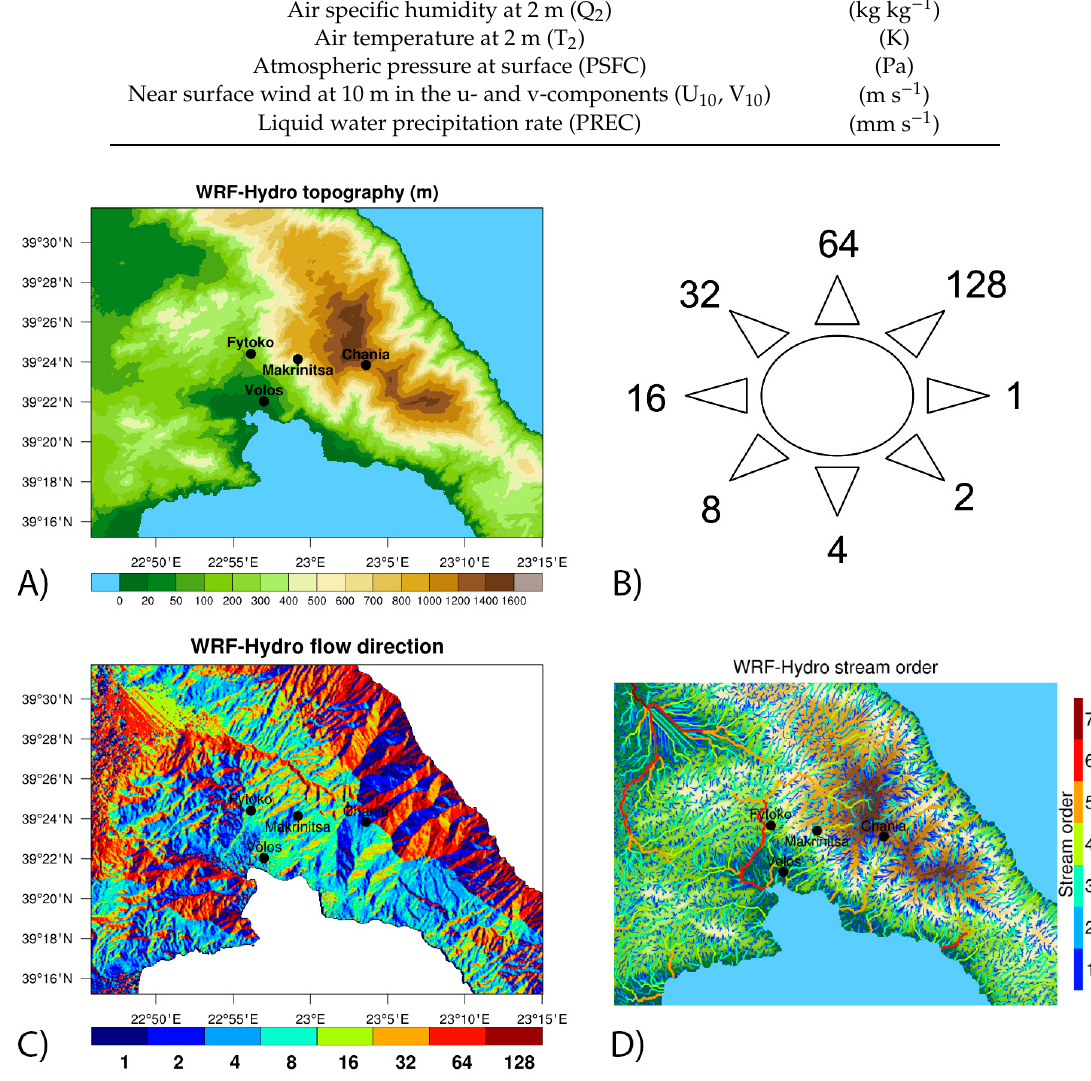
Figure 4. ( A ) WRF-Hydro version 5.0 hydrological model topography with horizontal resolution of 50 × 50 m and four areas represented by black dots: Volos, Fytoko, Makrinitsa, and Chania; ( B ) flow direction discretisation. The flow direction grid has integer values of 1, 2, 4, 8, 16, 32, 64, and 128, which are oriented in the depicted directions; ( C ) flow direction; ( D ) hydrographic and stream order map of the drainage basins used for the hydrological modelling.